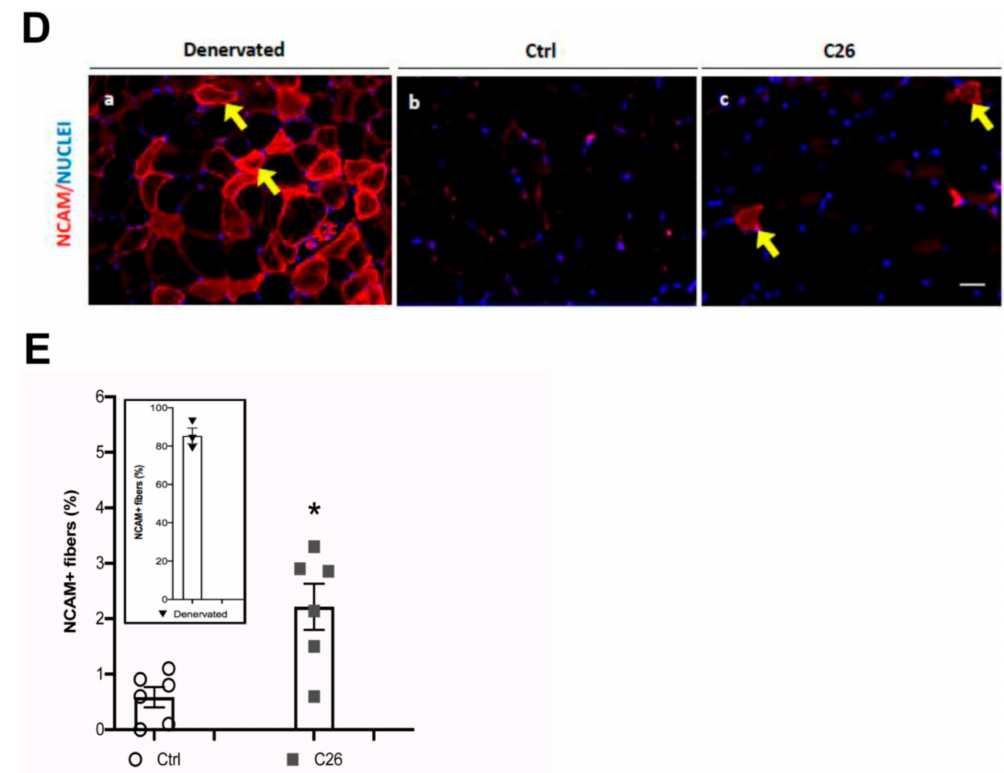
Figure 2. Central myonuclei are clumped in atrophic myofibers and their presence is associated to N-CAM upregulation in the tibialis of cachectic mice. ( A ) Photomicrographs of H&E-stained longitudinal sections of TA muscle, showing clumps of nuclei (arrows) in both healthy (a, Ctrl) and in cachectic (b, C26) muscles; however, in the latter, the frequency of clumps is significantly increased, as shown in the corresponding quantification ( B ); n = 6 for each group, * p < 0.05 by Student test. ( C ) Immunofluorescence analysis for MHC (red), laminin (green) and nuclei (blue) showing the occurrence of nuclear clumps (arrow) within the myofibers and not in the interstitial space, in longitudinal sections of the TA muscle. ( D ) Immunofluorescence analysis for N-CAM (red), nuclei are counterstained by Hoechst (blue) on transversal section of TA muscle. Fibers expressing high levels of N-CAM (arrows) are numerous in denervated muscles ( a , positive control), rare in controls ( b ) and significantly higher in cachectic muscles ( c ). NCAM is also detectable in satellite cells, which are distinguishable as dots. Quantification of the percentage of N-CAM + fibers is shown in ( E ), for control (Ctrl), cachectic (C26) and denervated (inset) muscles. Data are presented as mean +/ - SEM, n = 6 for each group. Scale bar is 10 µ m in panel A, 25 µ m in panel C and